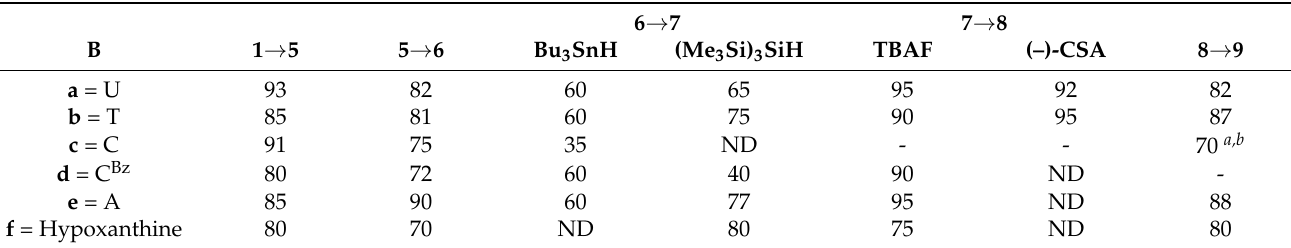
Table 2. Reaction yields of 5 , 6 , 7 , 8 and 9 .